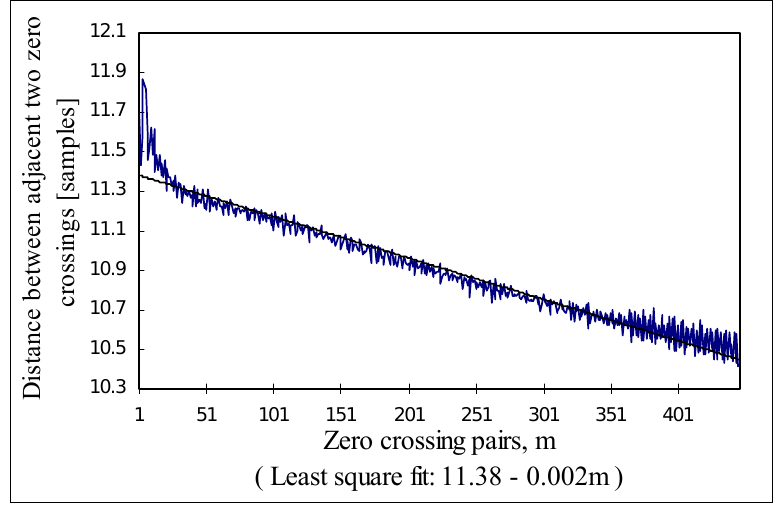
Figure 10 . Zero crossing period decrease in PZT scanning